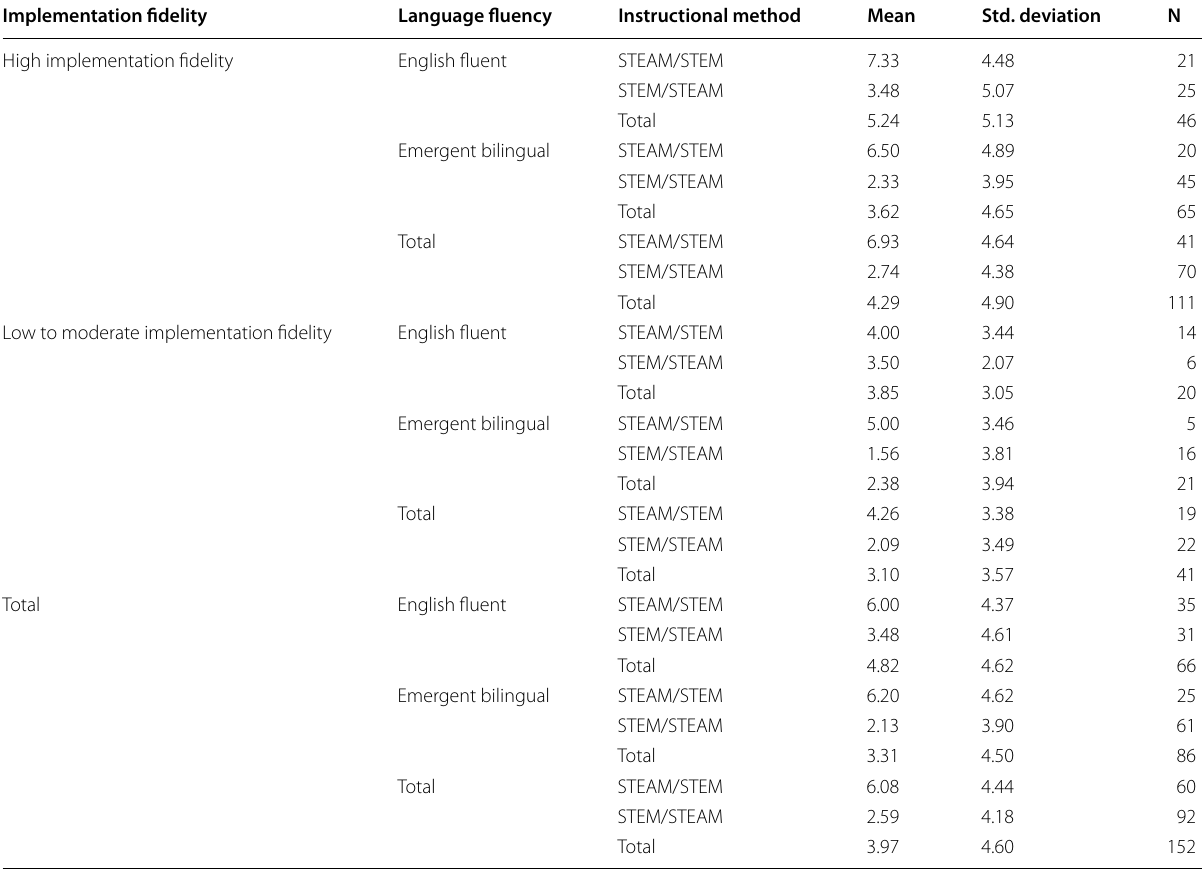
Table 2 Means analysis of implementation levels, English fluency and instructional method related to total change scores for physical science knowledge